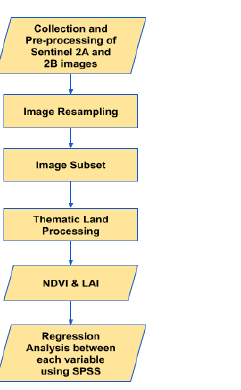
Figure 2. Flowchart for the NDVI Time Series and Ordinary Least Squares Regression